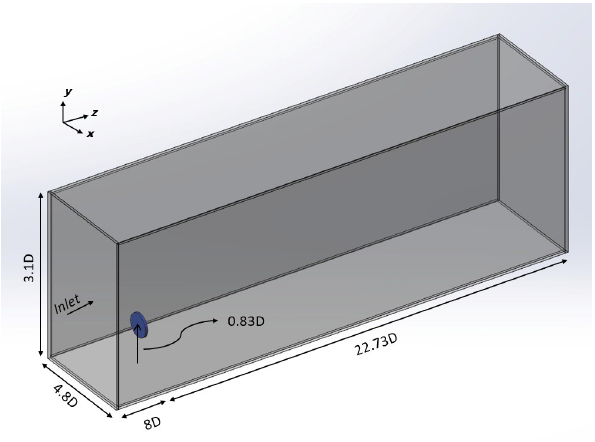
Figure 1. Numerical